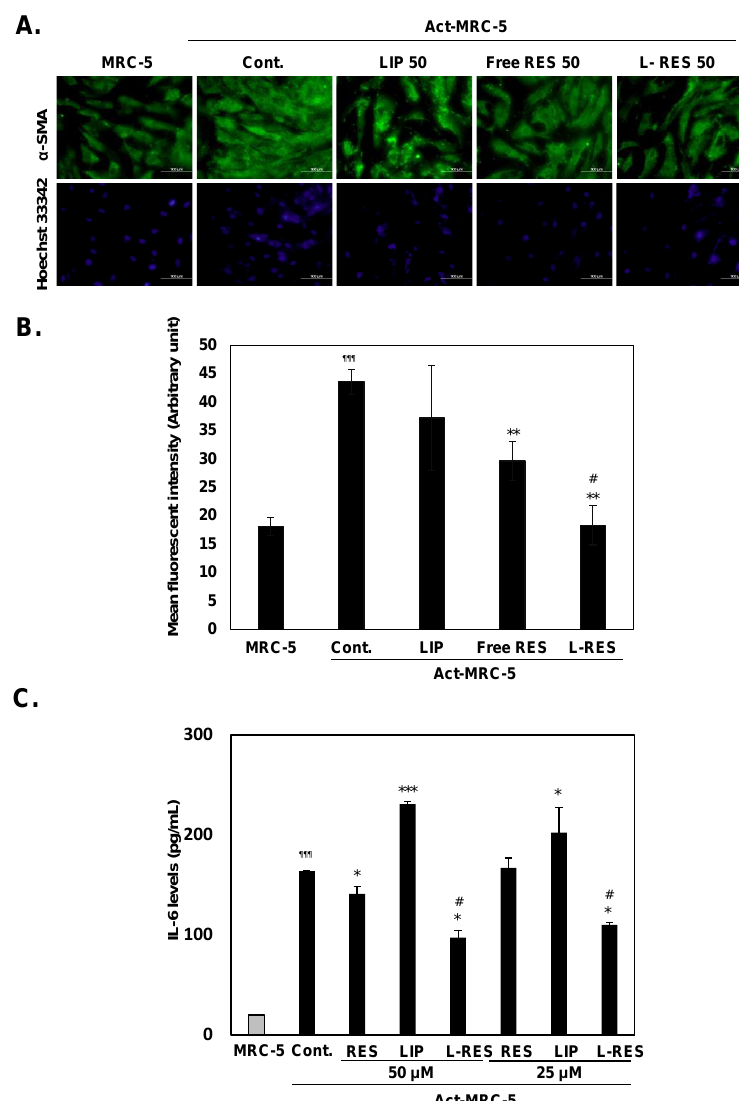
Figure 4. L-RES could inhibit activated fibroblast. The MRC-5 cells were activated with HT-29 cells derived in conditioned medium to become Act-MRC-5 activated fibroblasts. The Act-MRC-5 were then treated with RES, LIP, and L-RES at concentrations of 50 µM for 24 h. ( A ) Expression of α -SMA in Act-MRC-5-treated cells was determined by immunofluorescent staining. ( B ) Quantitative analysis of α -SMA expression. The quantitative data was analyzed from three different fields observing under microscope. ( C ) IL-6 levels in conditioned medium of Act-MRC-5-treated cells were determined by ELISA. * p < 0.05., ** p < 0.01, *** p < 0.001 vs Act-MRC-5 control. ¶¶¶ p < 0.001 vs MRC-5 control. # p < 0.05 vs free RES.